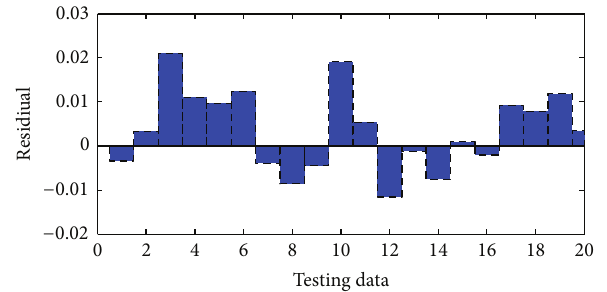
Figure 8: Residual between ANN and experimental for testing data.